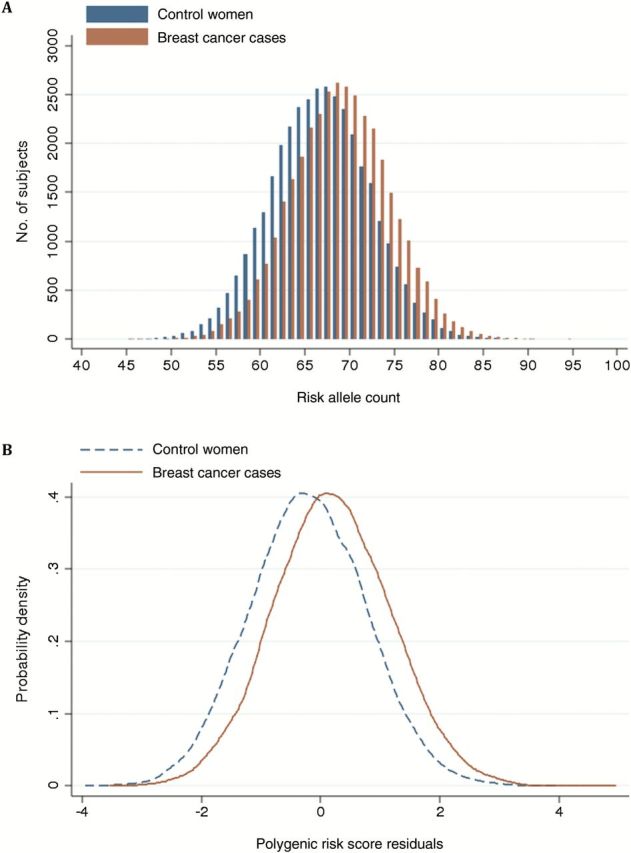

Distribution of the number of breast cancer risk alleles (A) and polygenic risk score residuals after adjusting the polygenic risk score (PRS) for study and seven principal components (B), in 33 673 breast cancer cases and 33 381 control women of European origin. The PRS approximated a normal distribution in both breast cancer cases and control women. The mean PRS was 0.69 for breast cancer cases and 0.49 for control women. PRS residuals are standardized Pearson’s residuals calculated after regression of the score on seven principal components.